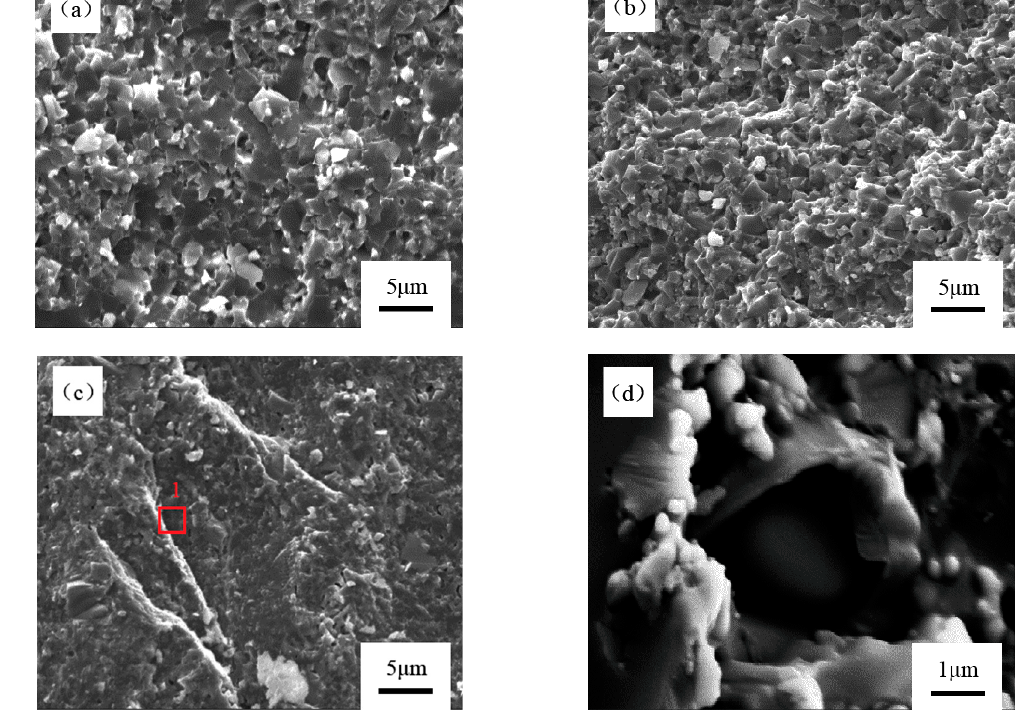
Figure 3. SEM (Scanning electron microscope) morphology: ( a ) 3 vol% ZrO 2 ; ( b ) 6 vol% ZrO 2 ; ( c ) 9 vol% ZrO 2 ; ( d ) mark 1 partial enlargement of ( c ).